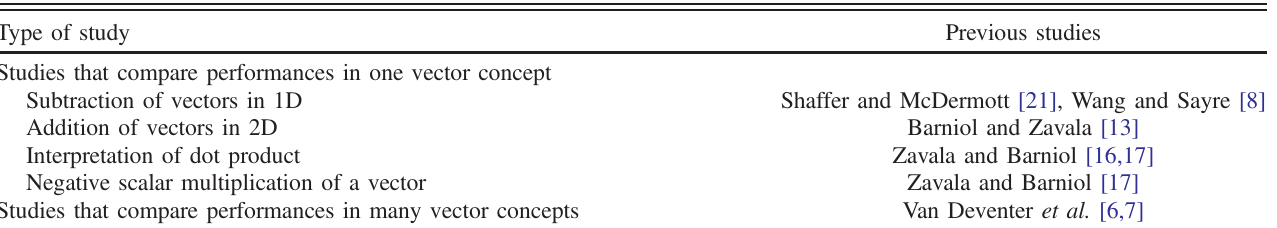
TABLE I. Classification of previous studies that compare students ’ performance in problems with and without physical context.